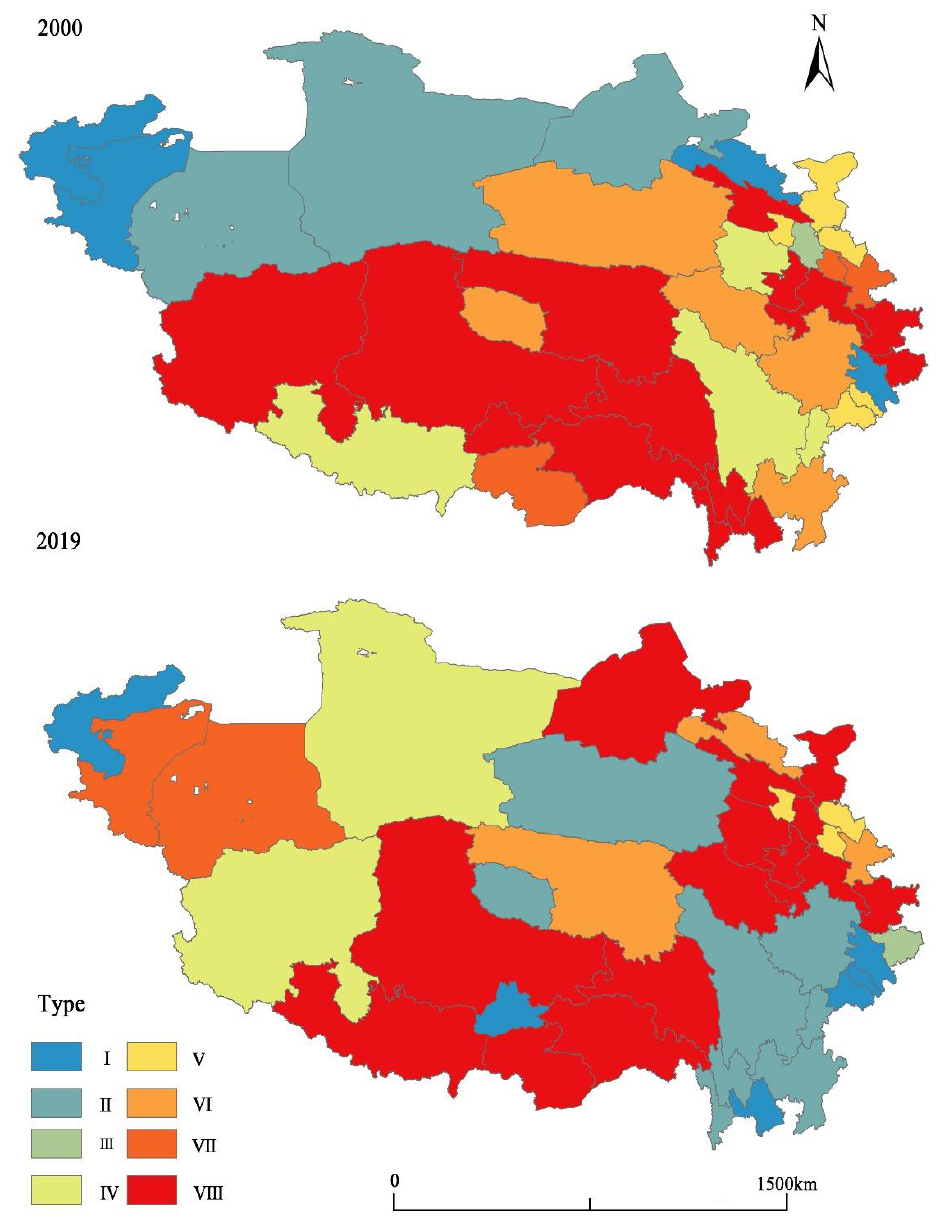
Figure 10. Spatial Pattern of Fractal Dimension Indexes Types of the Economic Security in the Qinghai – Tibet Plateau in 2000 and 2019.